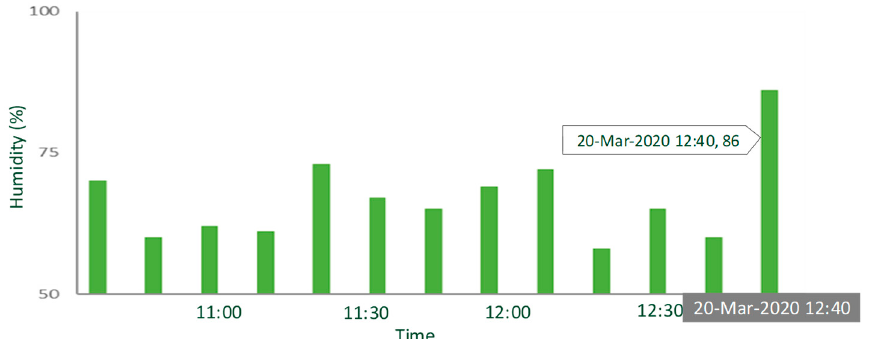
Mathematics 2020 , 8 , x FOR PEER REVIEW Figure 3. Monitoring room humidity over a period of time. Figure 3. Monitoring room humidity over a period of time.